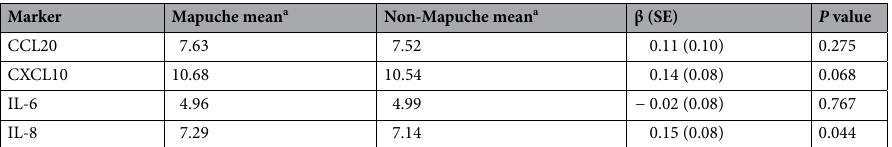
Table 2. Multivariable associations between ethnic group and 4 a priori inflammation markers. Adjusted for age group (50–54, 55–59, 60–64, 65–69, or 70–74 years), statin use, waist circumference (in cm), diabetes, smoking status (ever or never), education (0–8, 9–12, or ≥ 13 years of schooling attained), FONASA health coverage, and diet (fresh chili and fried food consumption). a Values are natural log